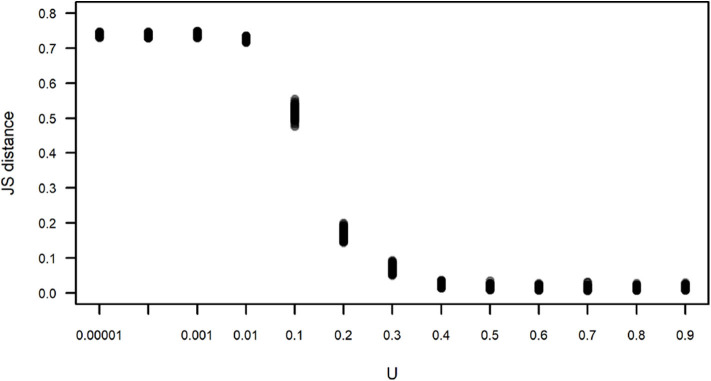
Jensen-Shannon (JS) distance between the observed and simulated subgroup size distributions shown in Figure 5. Each dot corresponds to the JS distance between an instance of 100 simulations for each value of U. For all simulations, L = −0.00001.